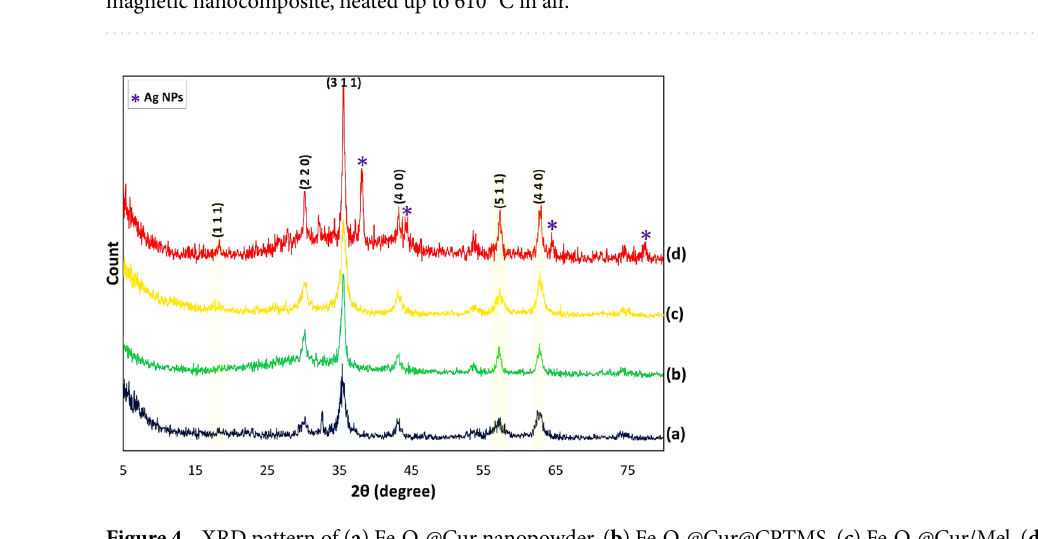
Figure 4. XRD pattern of ( a ) Fe 3 O 4 @Cur nanopowder, ( b ) Fe 3 O 4 @Cur@CPTMS, ( c ) Fe 3 O 4 @Cur/Mel, ( d )